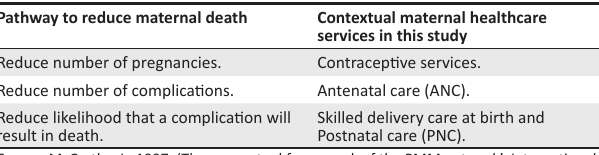
TABLE 1: Contextual maternal healthcare services to reduce maternal deaths. Pathway to reduce maternal death Contextual maternal healthcare services in this study Reduce number of pregnancies. Contraceptive services. Reduce number of complications. Antenatal care (ANC). Reduce likelihood that a complication will Skilled delivery care at birth and result in death. Postnatal care